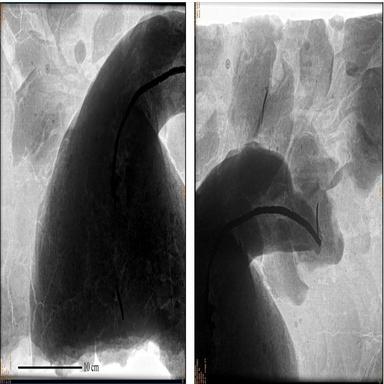
Two details of the radiography of the body of the eagle, in which the metal elements are visible.